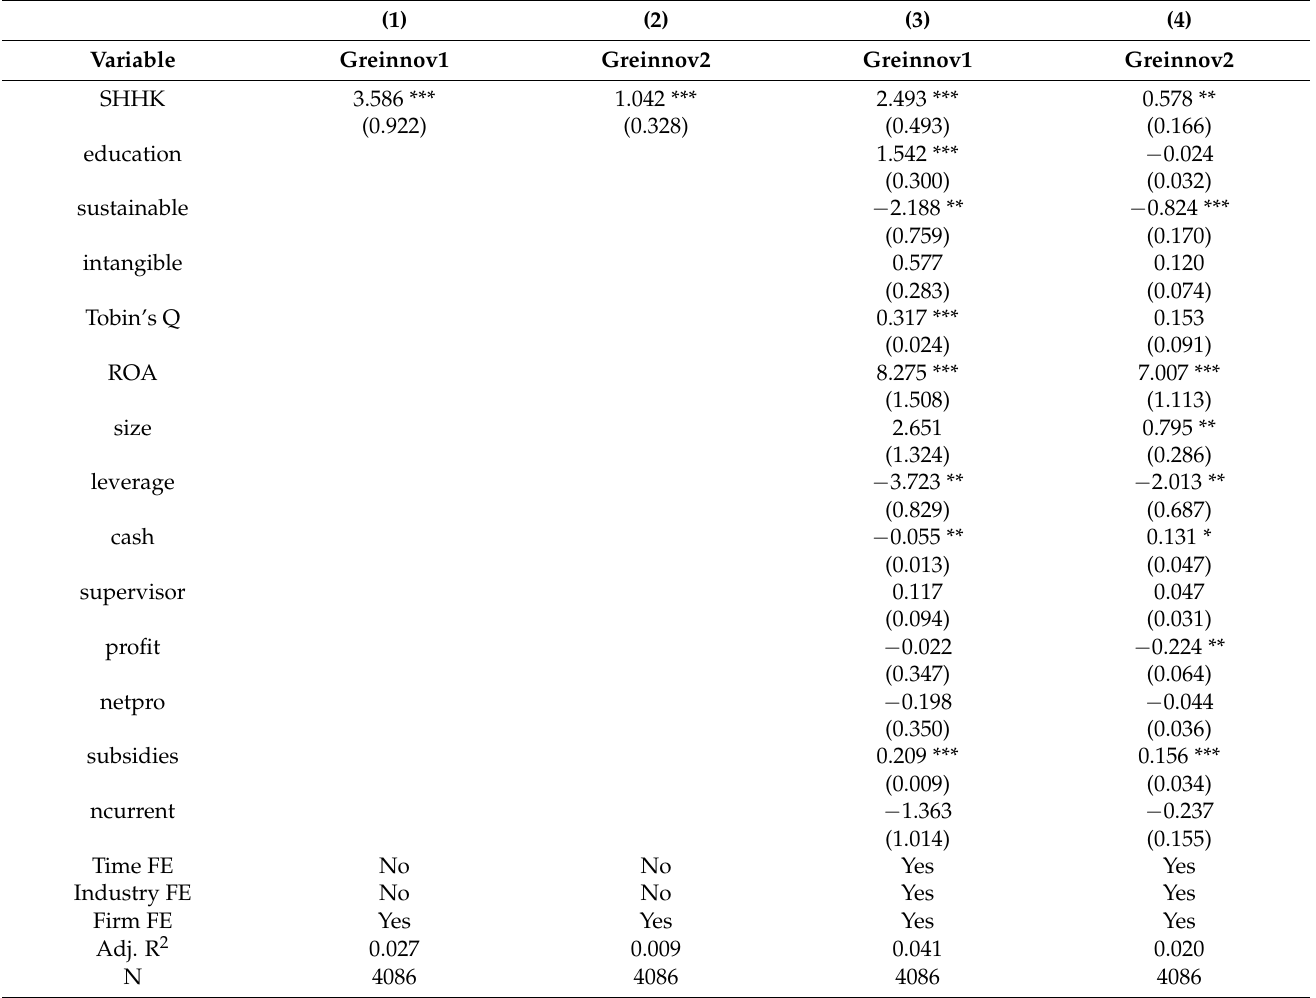
Table 2. Regression results of direct effects of main